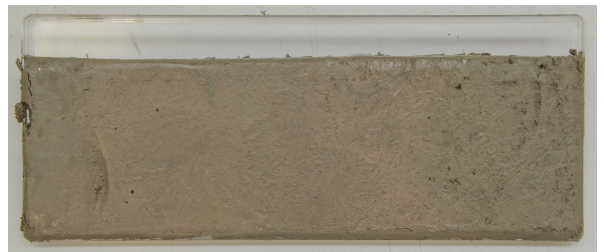
Figure 2. Sediment slab (25cm × 10cm) stabilized in Plexiglas lid ready for X-raying. Top of core is to the left.